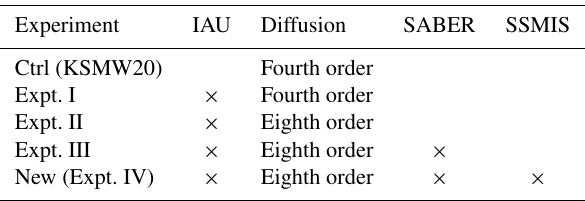
Table 2. Notation for the different experiments considered in this